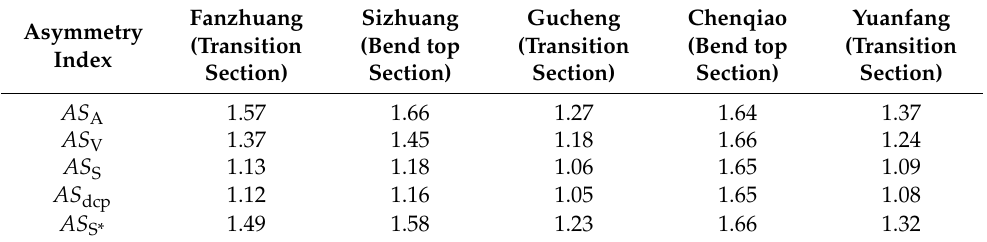
Table 4. Asymmetry index of wandering river bend top and transition section (scouring state, S = 5 kg/m 3 ).